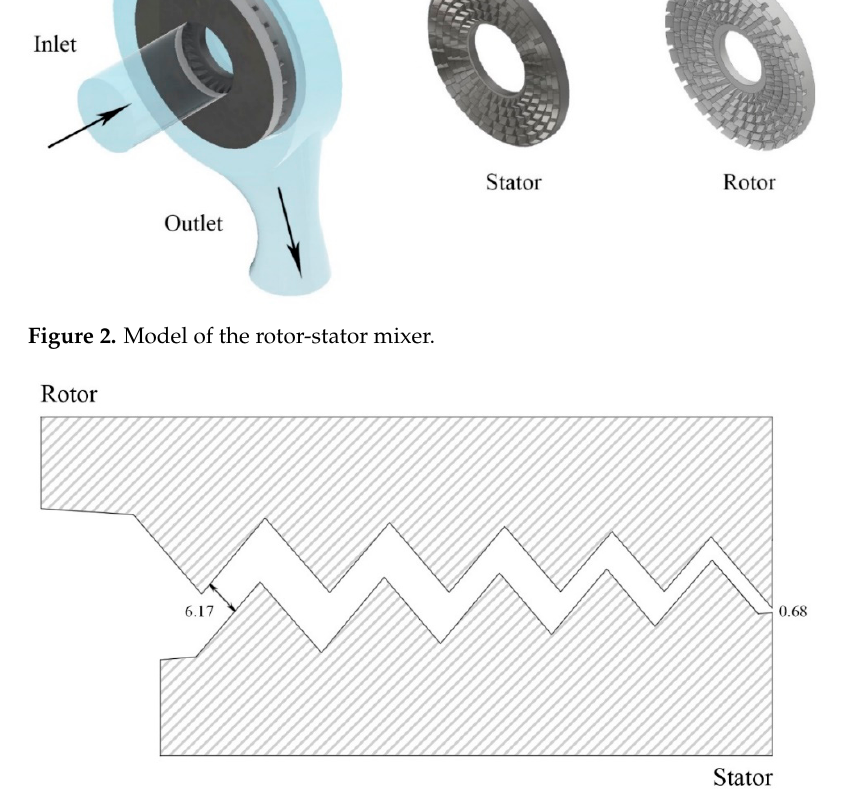
Figure 3. Cross-secton of the rotor and stator interface. Table 2. Process parameters of the rotor-stator homogenizer.